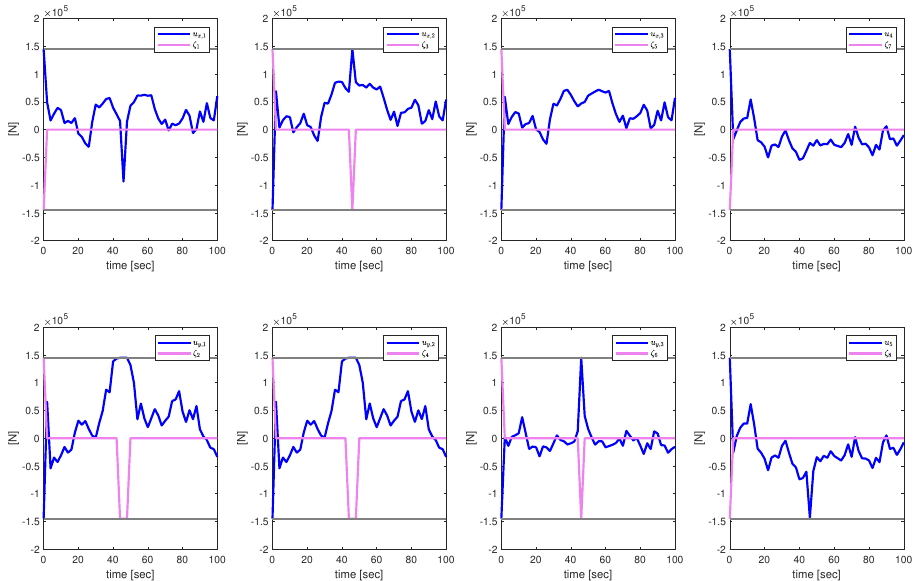
Figure 8. Time response of control inputs provided by each actuator under ERPI